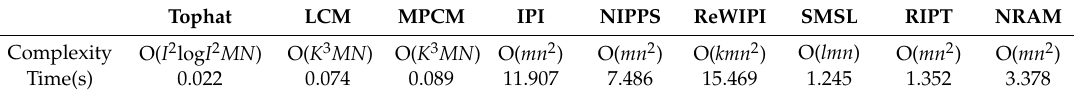
Figure 13. Convergence rates of the IPI, NIPPS, ReWIPI, SMSL, RIPT and NRAM models. Table 5. Comparison of computational complexity and computing time of nine methods.